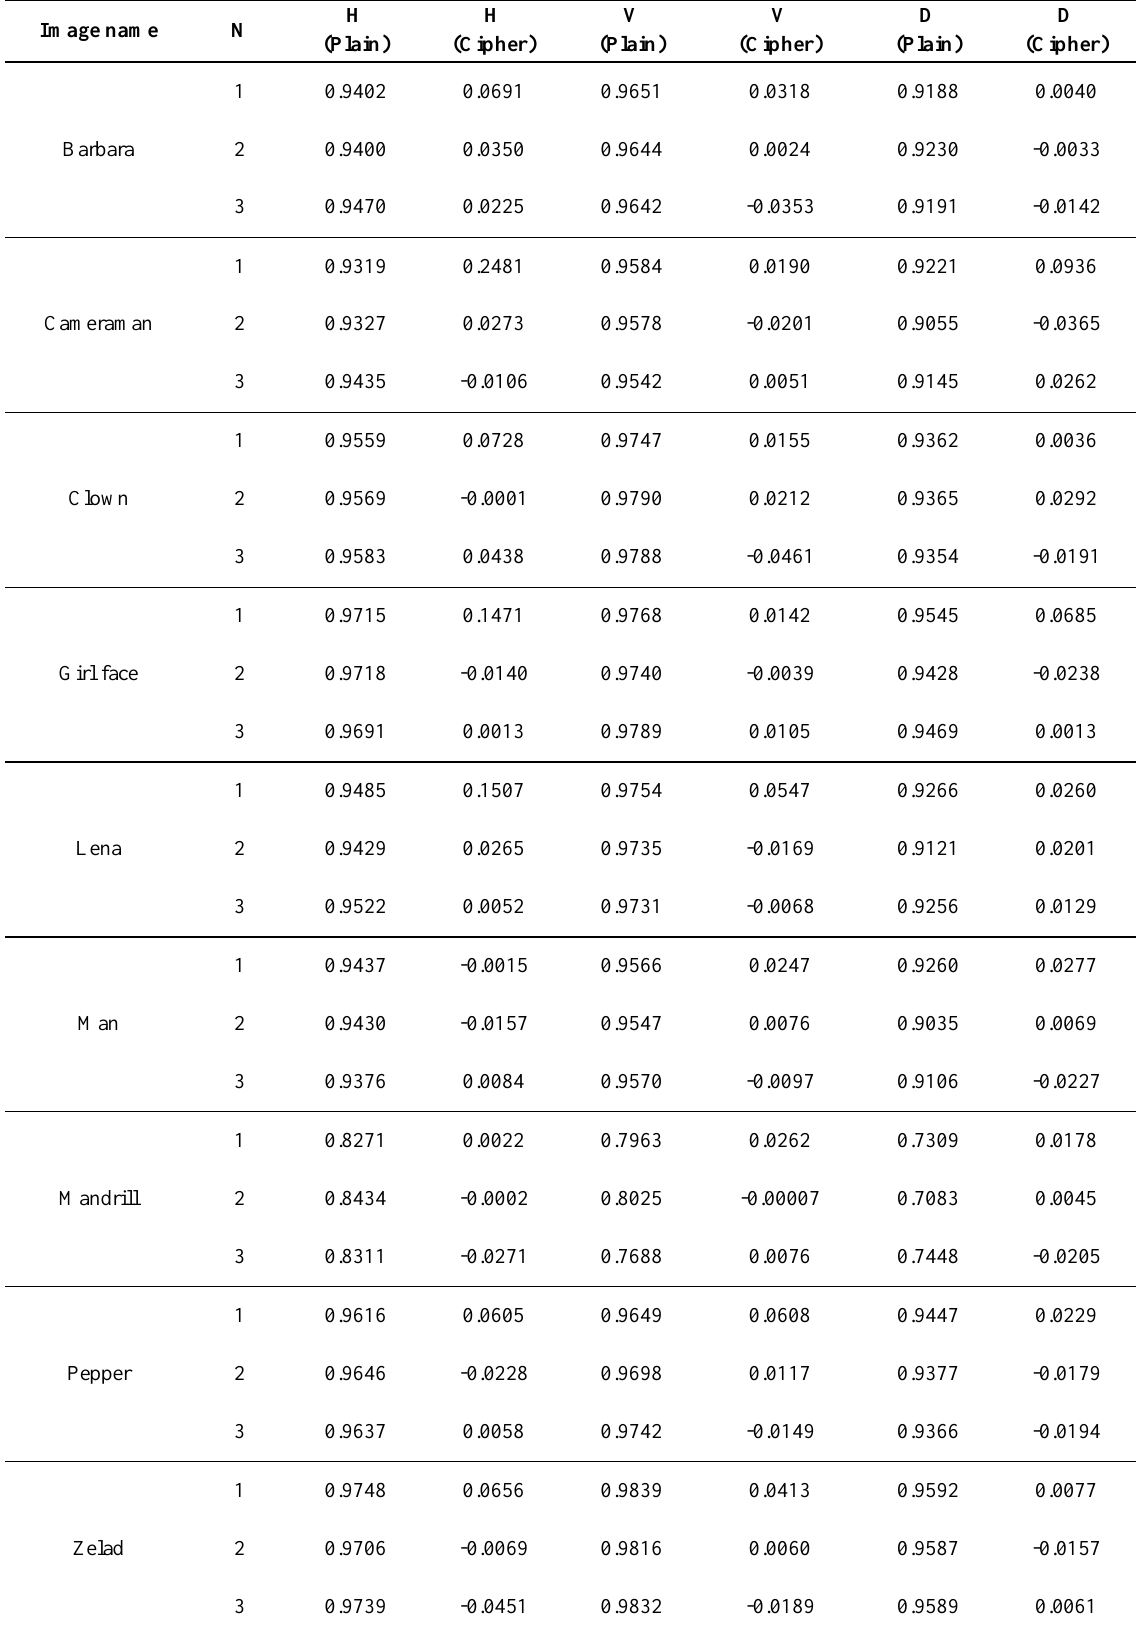
Table 5. The correlation coefficients of the plain and cipher images in all the cases of